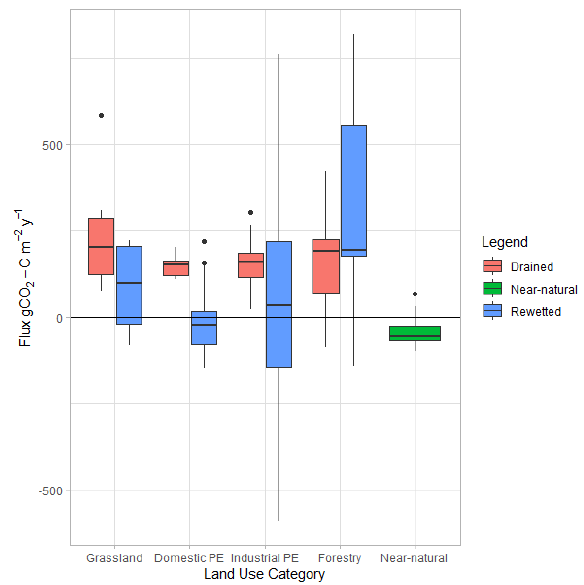
-C) Figure 4. Boxplot of annual methane (CH 2 (g C m - ² y - ¹) from Irish peatlands. Boxplots show median flux (line) with 25 th to 75 th interquartile range as the extent of the coloured box. Error lines denote the range of values. Positive values indicate emissions from the soil and negative values indicate removals from the atmosphere. PE = Peat